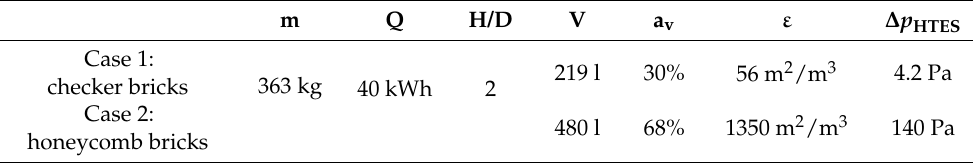
Table 2. Parameters of the HTES models for the different case